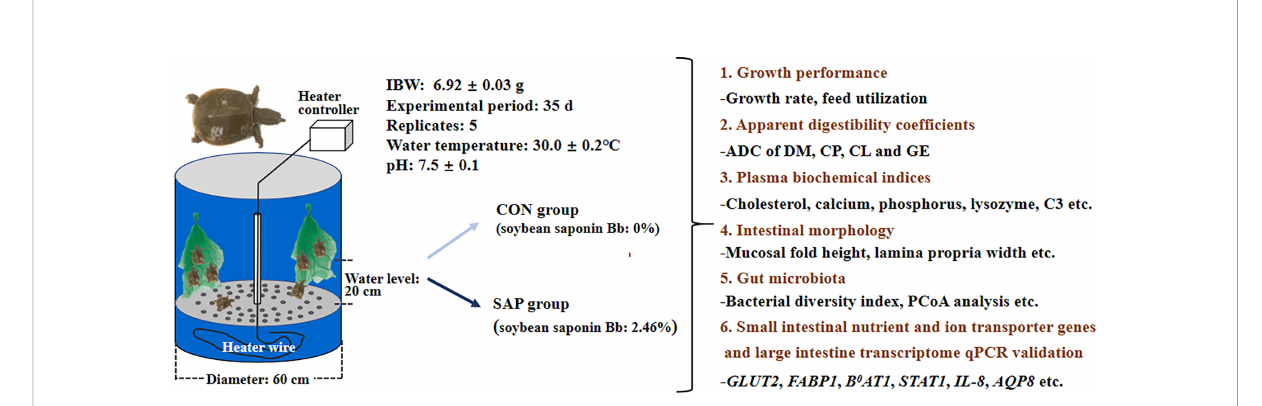
FIGURE 1 Flow chart of experimental